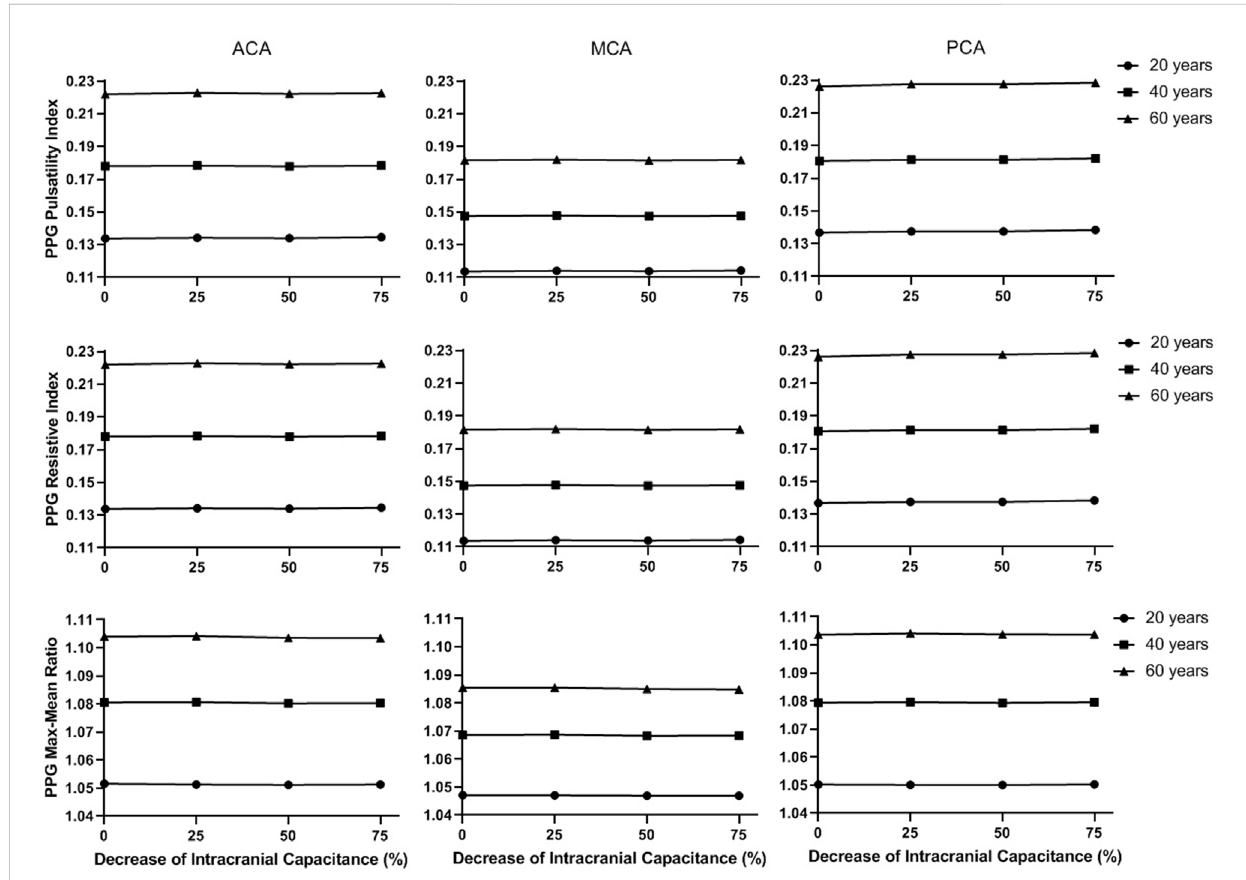
FIGURE 10 The secondary waveform features of the simulated PPG signals in different intracranial capacitance conditions.